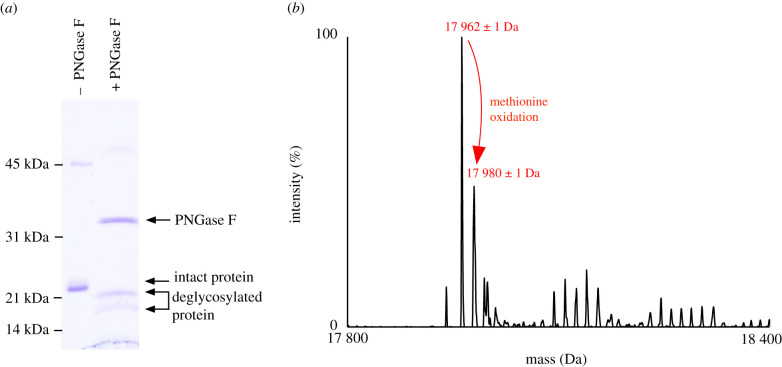
Deglycosylation of the possum urinary protein. (a) Pooled male urine was incubated with PNGase F and analysed by SDS-PAGE, in which an increased mobility was observed in the enzyme-treated sample. (b) This reduction in molecular weight was confirmed by intact mass analysis, in which a single predominant peak of 17 962 Da was observed.